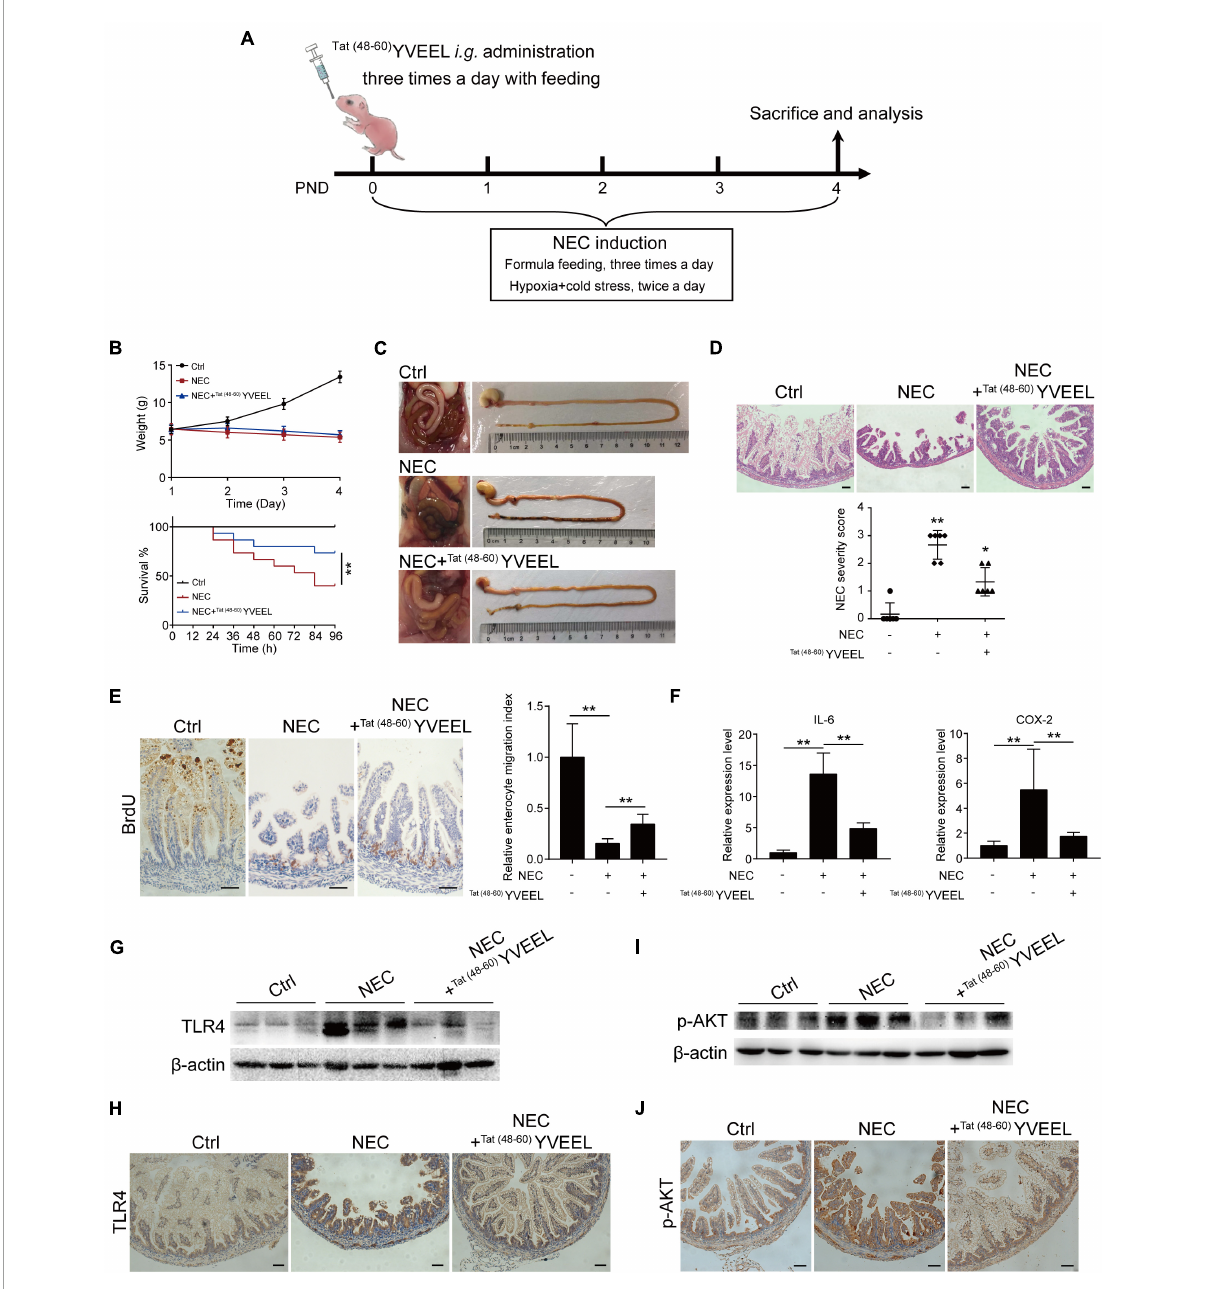
FIGURE5 Tat ( 48 - 60 ) YVEEL promotes migration of enterocytes and reduces the severity of experimental NEC. (A) Experimental model of NEC–a timeline of treatment strategy. PND: postnatal day. (B) Body weight and survival rate of rat pups after experimental NEC with or without Tat ( 48 - 60 ) YVEEL treatment; (C) representative photographs of the intestines of newborn mice that were mother fed (Ctrl), exposed to experimental NEC (NEC), or exposed to experimental NEC with daily oral gavage with Tat ( 48 - 60 ) YVEEL at 10 mg/kg (NEC + Tat ( 48 - 60 ) YVEEL); (D) representative photomicrographs of the terminal ileum of the indicated group, bar = 200 µ m, quantification of NEC severity score in the group indicated were shown in the bottom, * p < 0.05, ** p < 0.01; (E) pups in the indicated group were injected with BrdU 4 h before killing and immunostained with BrdU. Micrographs showing the migration of enterocytes in the terminal ileum of the indicated group, enterocyte migration index was quantified by measuring the ascent of BrdU-labeled enterocytes from the crypt to the villus, bar = 200 µ m; (F) qRT-PCR of IL-6 and COX-2 in intestine of the pups in the indicated group, * p < 0.05, ** p < 0.01; (G) Western blot analysis showing the TLR4 expression in intestine of the pups in each group; (H) TLR4 immunostaining was performed on the sections of terminal ileum in the indicated group, bar = 200 µ m; (I) Western blot analysis showing the p-AKT expression in intestine of the pups in each group; (J) p-AKT immunostaining was performed on the sections of terminal ileum in the indicated group, bar = 200 µ